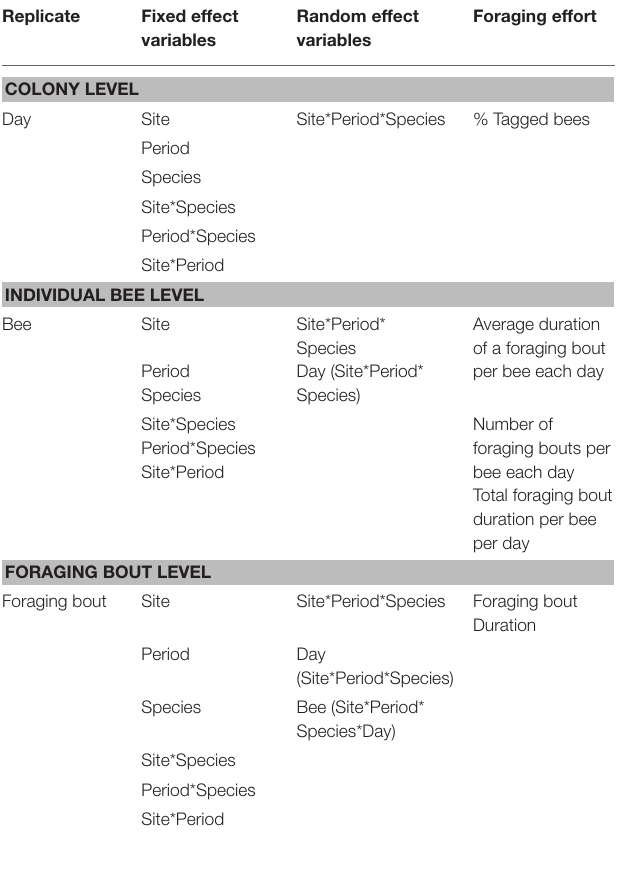
TABLE 2 | The linear mixed effect models used to examine the impact of site, time period, bee species, and their interactions on the different metrics of bee foraging effort, at the colony, individual bee, or foraging bout